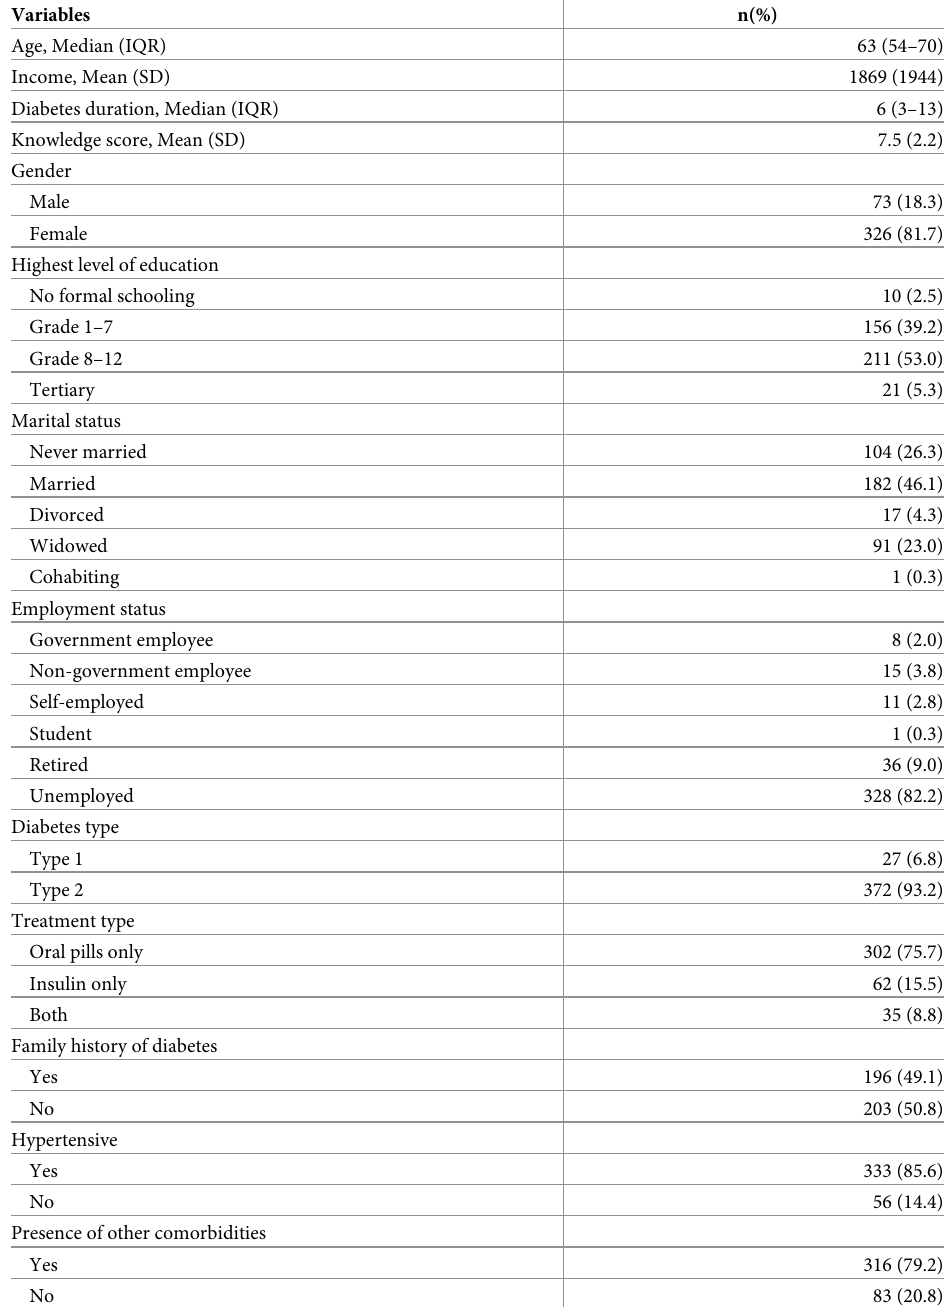
Table 1. Demographics